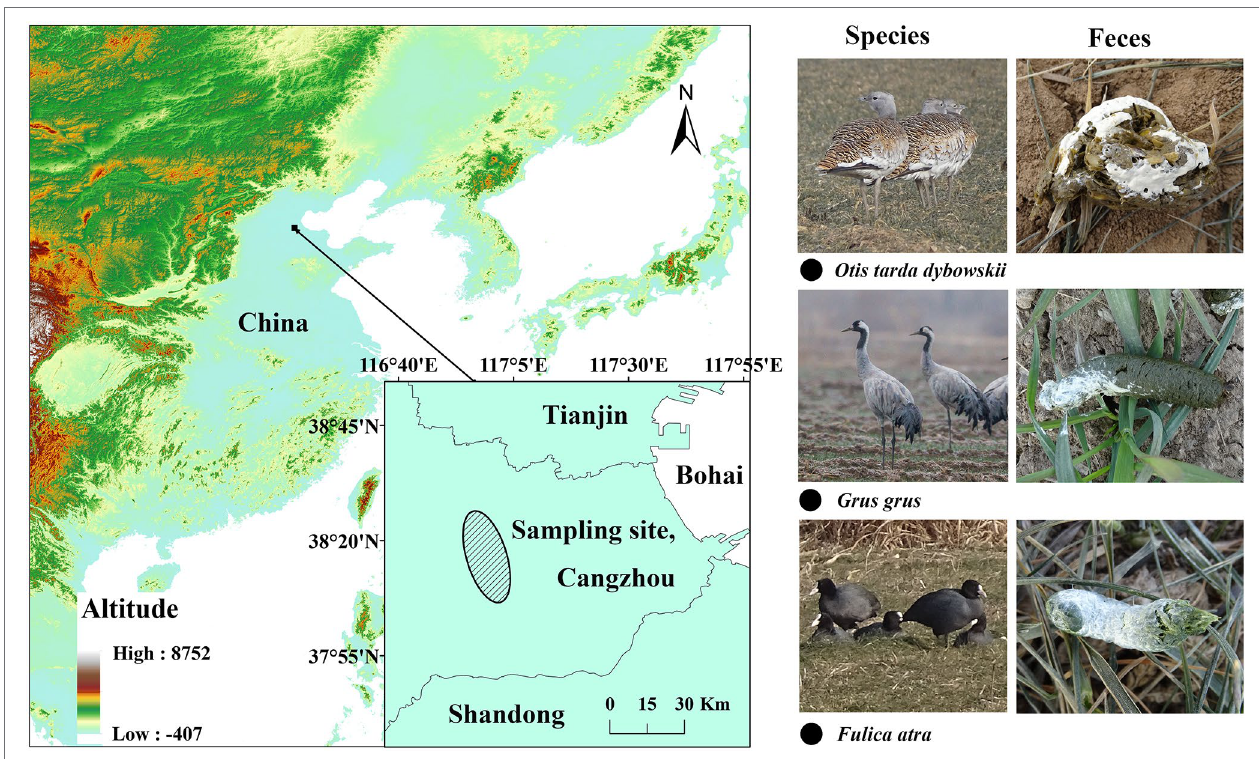
FIGURE 1 | Fecal-sampling sites of the three wintering wild bird